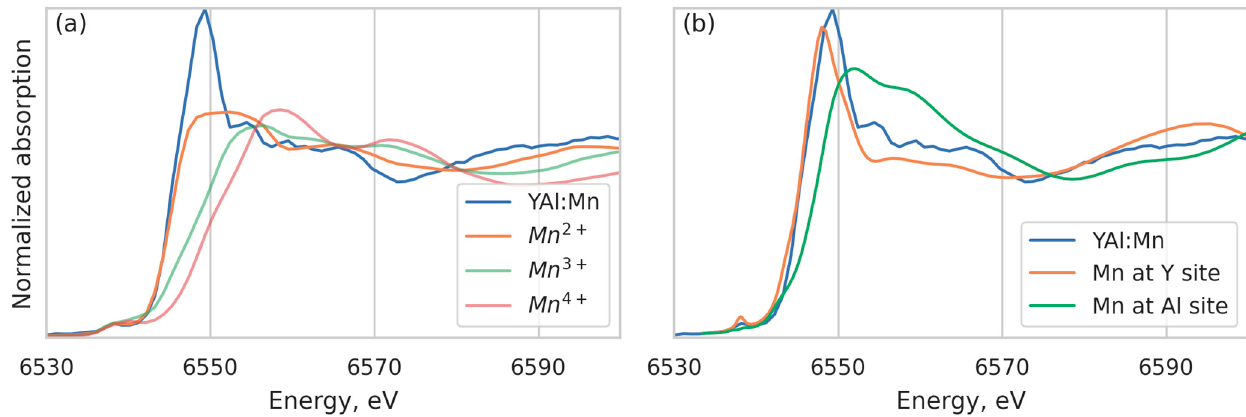
Figure 4. K-edge absorption spectra of Mn in YAB:Mn compared with the “reference” Mn 2+ , Mn 3+ , and Mn 4+ spectra ( a ); calculated XANES spectra for Mn at the Y 3+ and Al 3+ sites in YAB crystal structure compared with experimental spectrum ( b ).